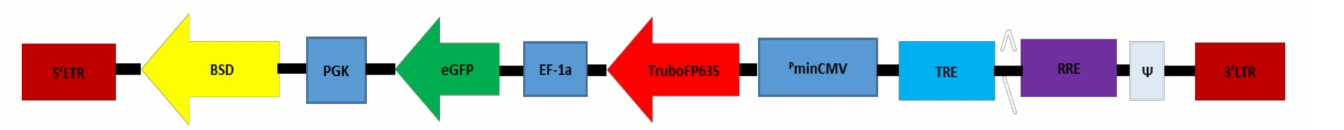
Figure 1. Schematic presentation of lentivirus transfer plasmid pTet-turboFP635-EF-1a-eGFP-PKG-BSD. Transfection of HEK 293T